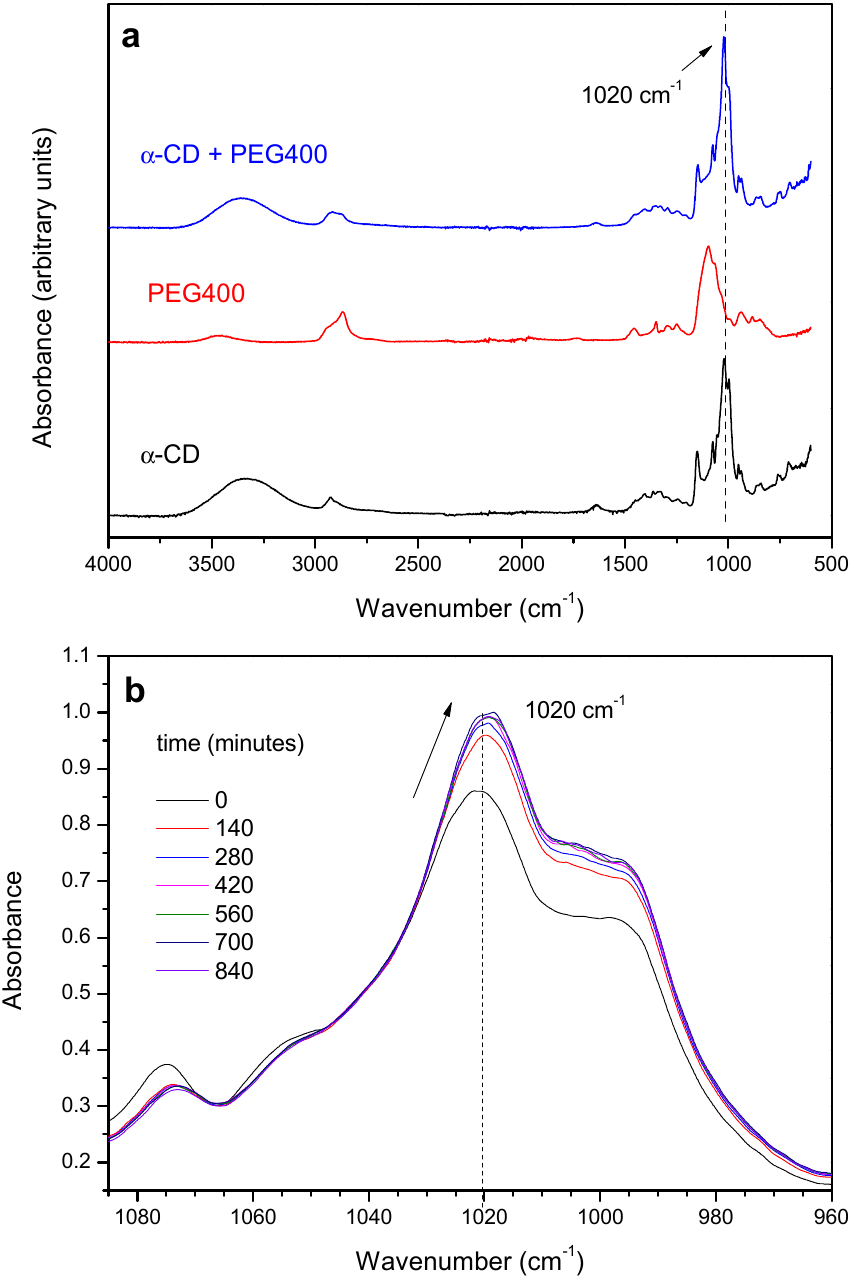
Figure 1. ( a ) FTIR-ATR spectra of α -CD, PEG400 and the reaction product after 120 min at 65 °C (1:1 feed ratio); ( b ) Expansion of the 960–1100 cm − 1 region of the spectra an evolution with time. The reaction between the α -CD and PEG results in the gradual increase of the ab- sorbance of the C-O stretching mode of the macrocycle at 1020 cm − 1 and in a slight red-shift of ca. 3 cm − 1 , with the occurrence of an isosbestic point at ca. 1040 cm − 1 , as shown in Figure 1b. The relatively small changes observed are in line with the formation of a non- covalent structure stabilized by van der Waals forces, in which the EO monomers replace the water molecules included in the CD. The evolution of the absorbance of the 1020 cm − 1 band of the α -CD has been tracked as a function of time and temperature. As an example, Figure 2a shows the kinetic profile of the 1:1 mixture at 55 ◦ C. The experimental data have been fitted to an exponential decay function with offset (see Supplementary